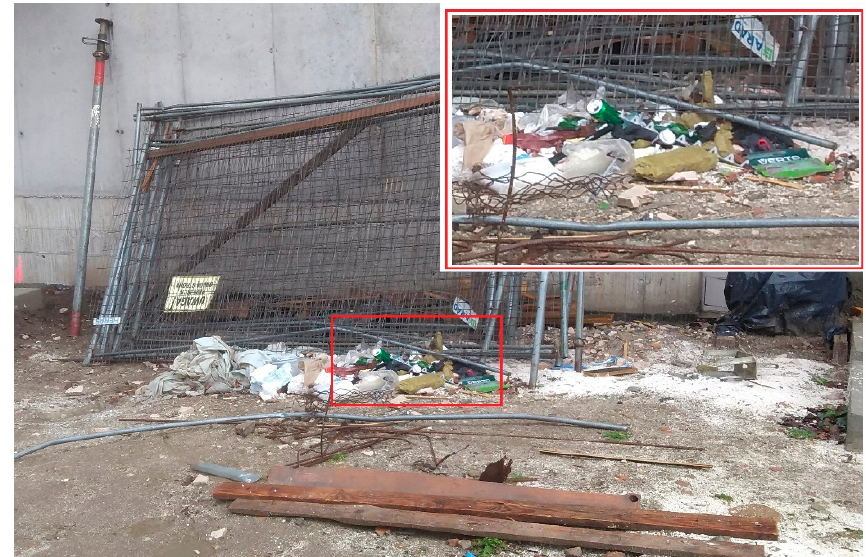
Figure 13. An abandoned beer can at a litter site at the examined construction site (authors’ archive).